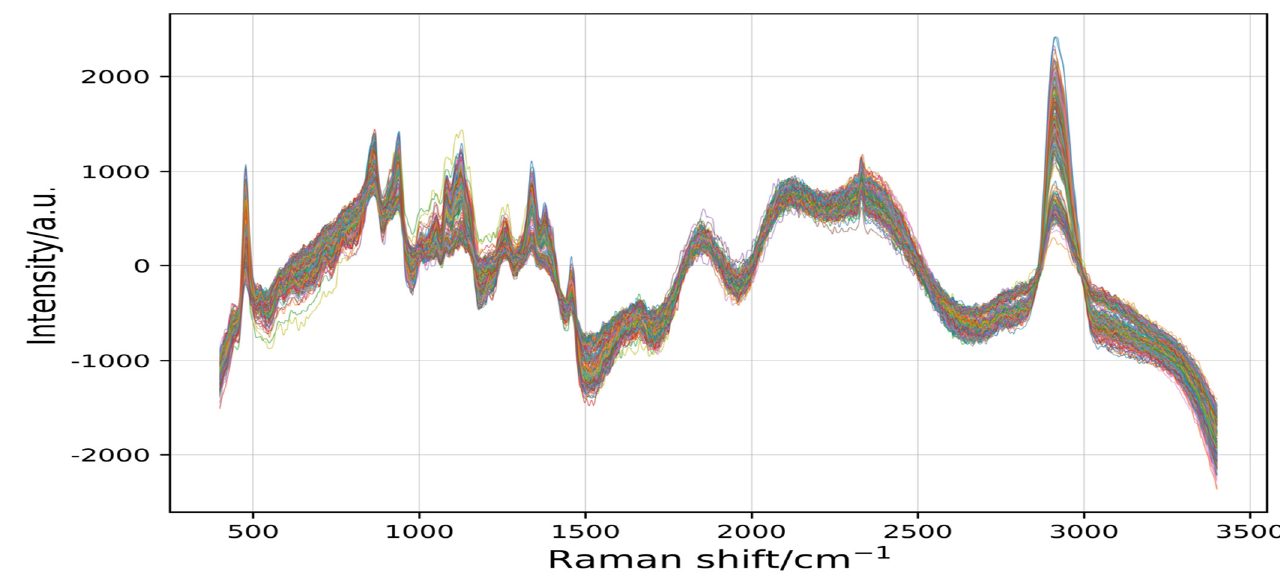
Figure 6. The curve of the peak information extracted by the difference method for 245 samples.